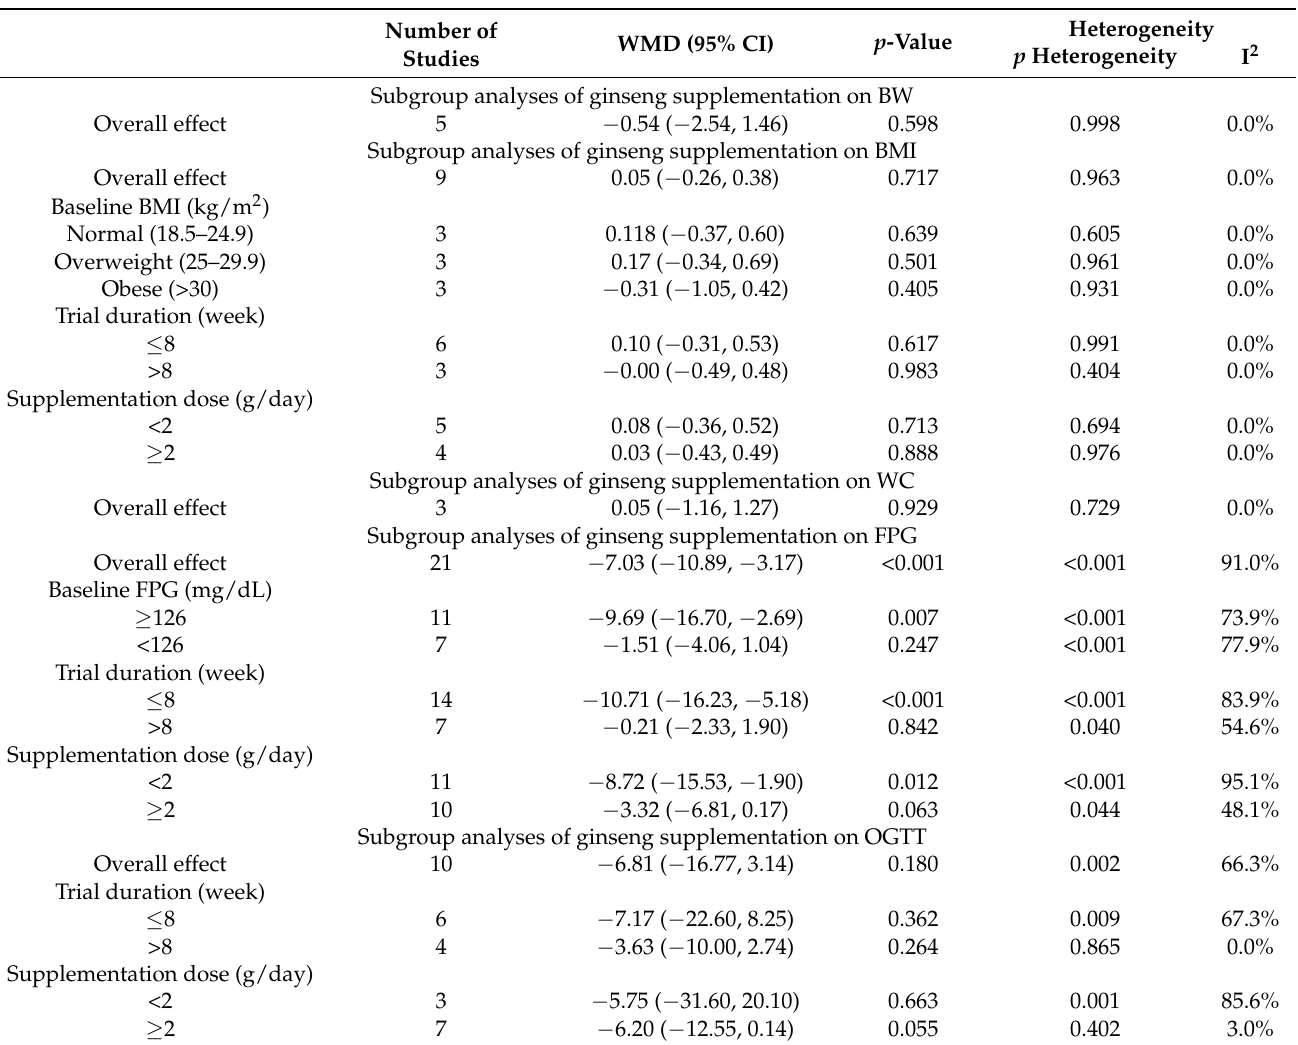
Heterogeneity p Heterogeneity I